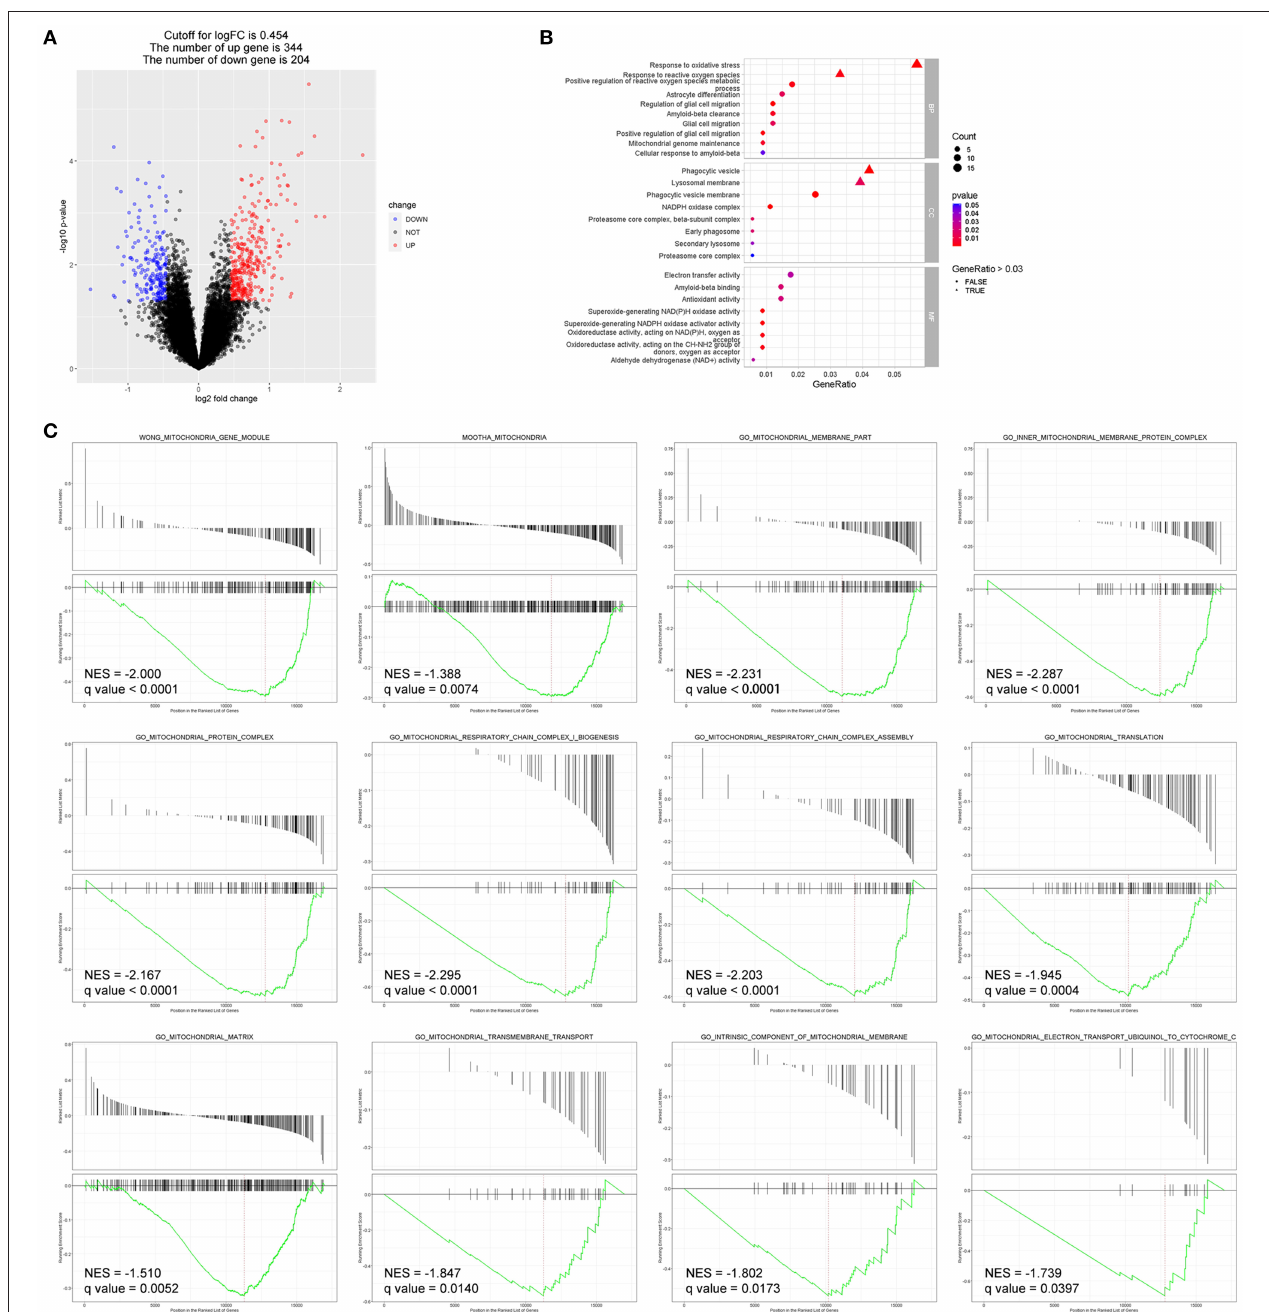
FIGURE 5 | Bioinformatics analyses identified DEGs and enriched pathways in AMD (GEO: GSE135092). (A) The DEGs between the two groups are displayed by volcano map, including 344 upregulated genes and 204 downregulated genes ( p < 0.05). (B) Enriched GO terms of interest were displayed after GO enrichment analysis of DEGs ( p < 0.05). (C) GSEA of the mitochondria-related gene sets enriched in AMD retinas as compared to control retinas ( q -value < 0.05). BP, biological process; CC, cellular component; MF, molecular function; NES, normalized enrichment score.